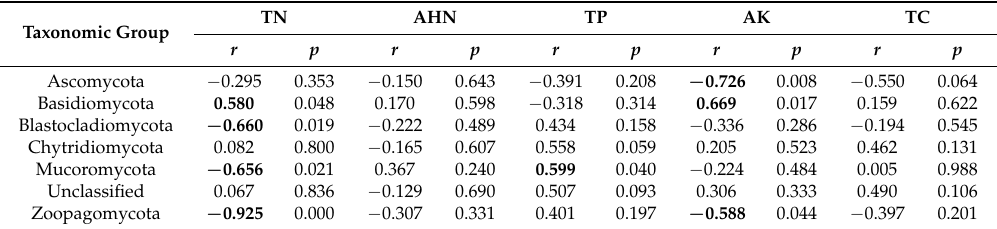
Table 3. Pearson’s correlation ( r ) and significance ( p ) values between the relative abundances of the eight most abundant fungal phyla and the soil physicochemical properties.